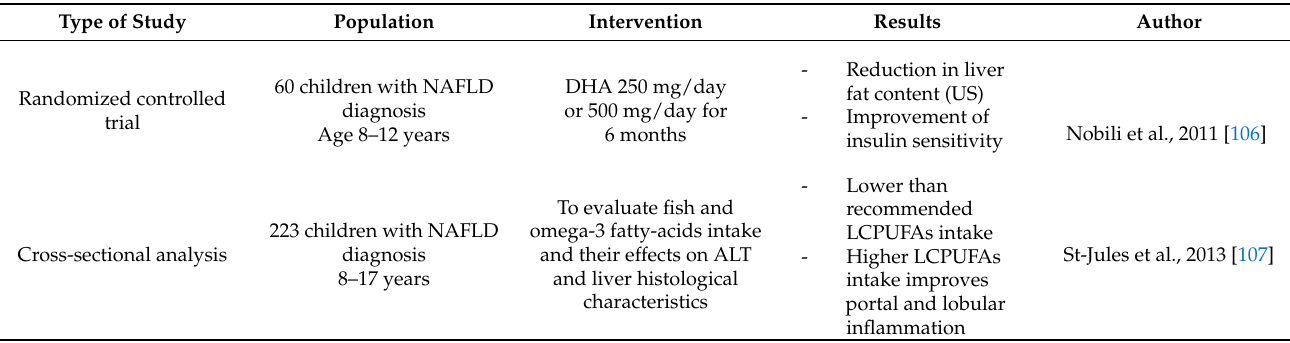
Table 5. Studies on the LCPUFAs’ effects in pediatric Non-Alcoholic Fatty Liver